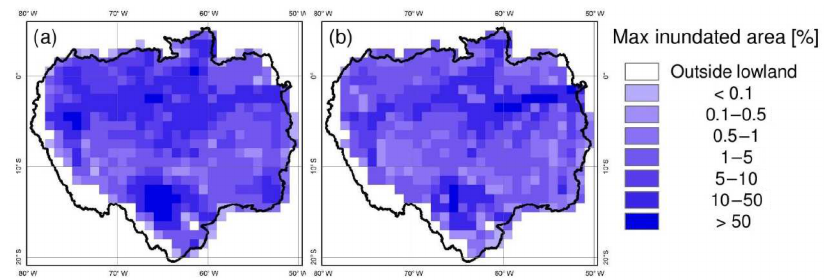
Figure 9. Maximum inundated proportion in the lowland ( < 500m altitude) Amazon basin during the years 1995–1996: (a) observed (after Hess et al., 2015) versus (b) simulated in ORCHILEAK, y = 0 . 04 + 0 . 90 · x , R 2 = 0 . 56, RMSE = 11%. Table 6. Observed and simulated DOC concentrations in overland flow ( = F RO ) and headwater streams ( = F fastout + F slowout ). Source Rain Runoff Surface runoff Component DOC conc. (mmyr − 1